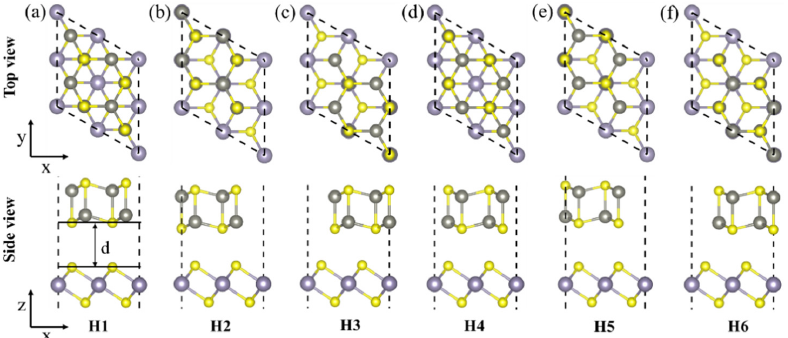
Figure 3. Top and side views of ( a ) H1, ( b ) H2, ( c ) H3, ( d ) H4, ( e ) H5, and ( f ) H6 stacking models of ZnS/SnS 2 heterojunction after atomic relaxation. Table 2. Calculated equilibrium interlayer distance, d, binding energy, E b , other direction, L Zn-S(a) , vertical direction, L Zn-S(b) , and bond lengths, L Sn-S , of ZnS/SnS 2 heterostructure for six models. Models